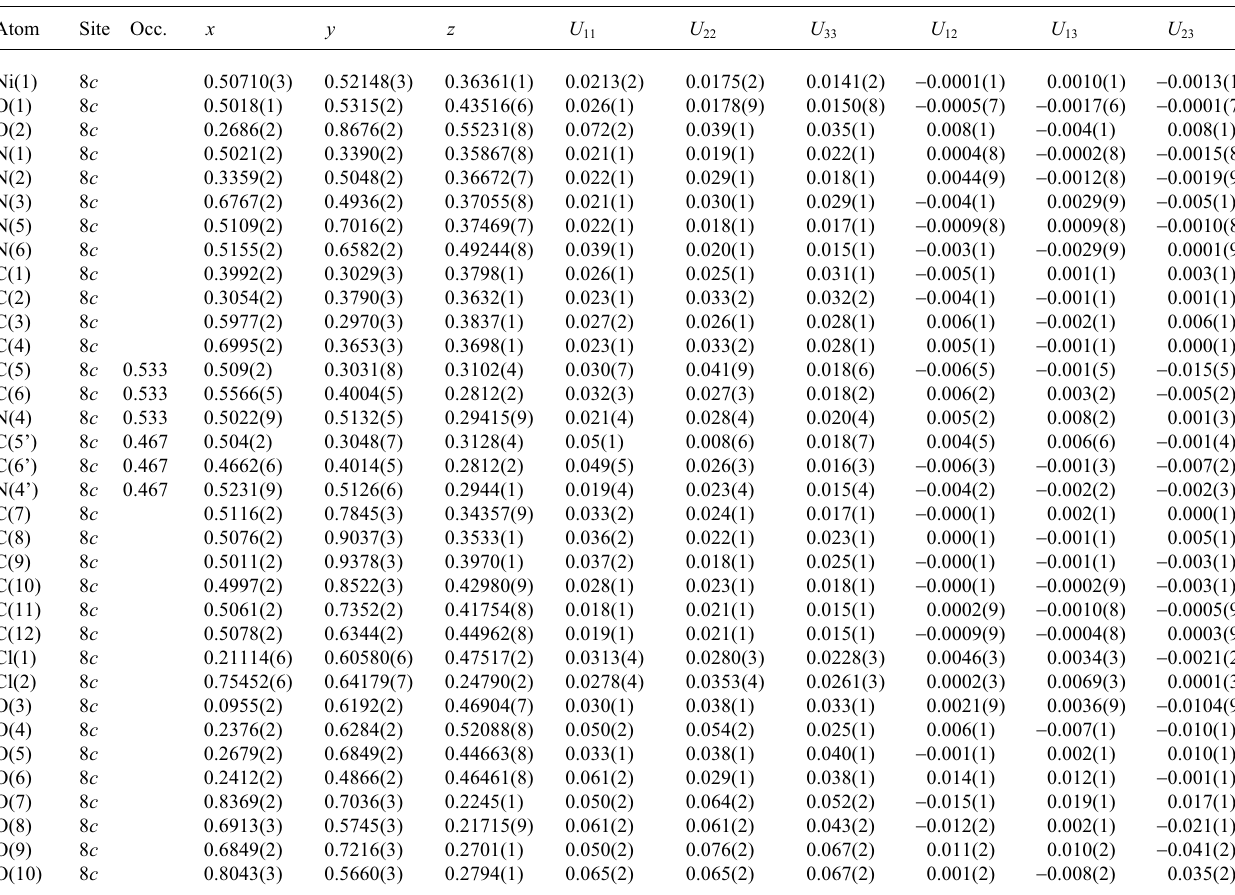
Table 3. Atomic coordinates and displacement parameters (in Å 2 ) .